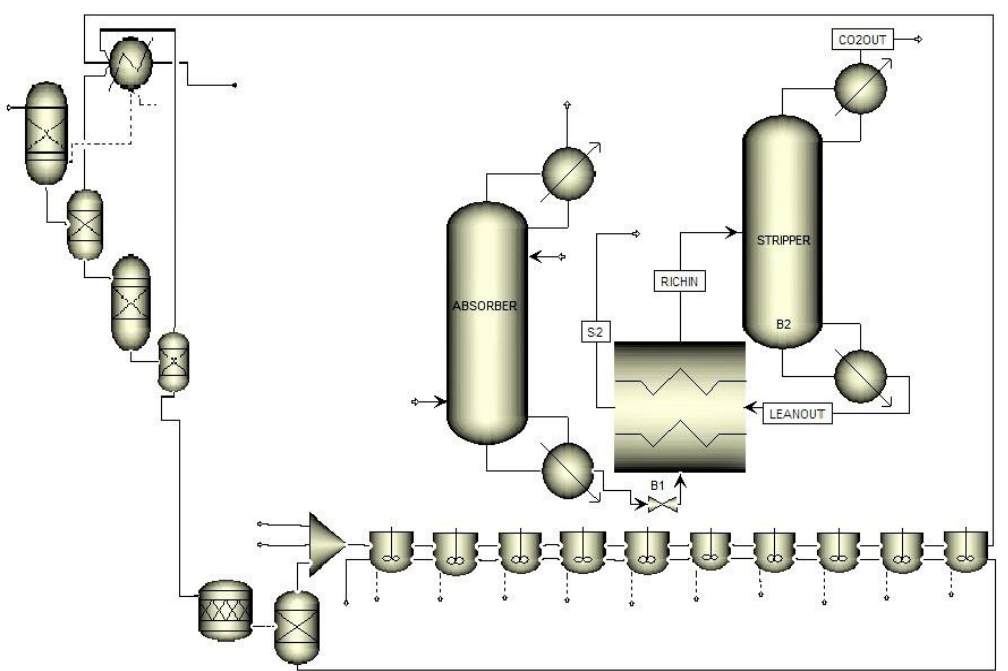
Figure 5. Gaseous fraction of lignite Thar coal.